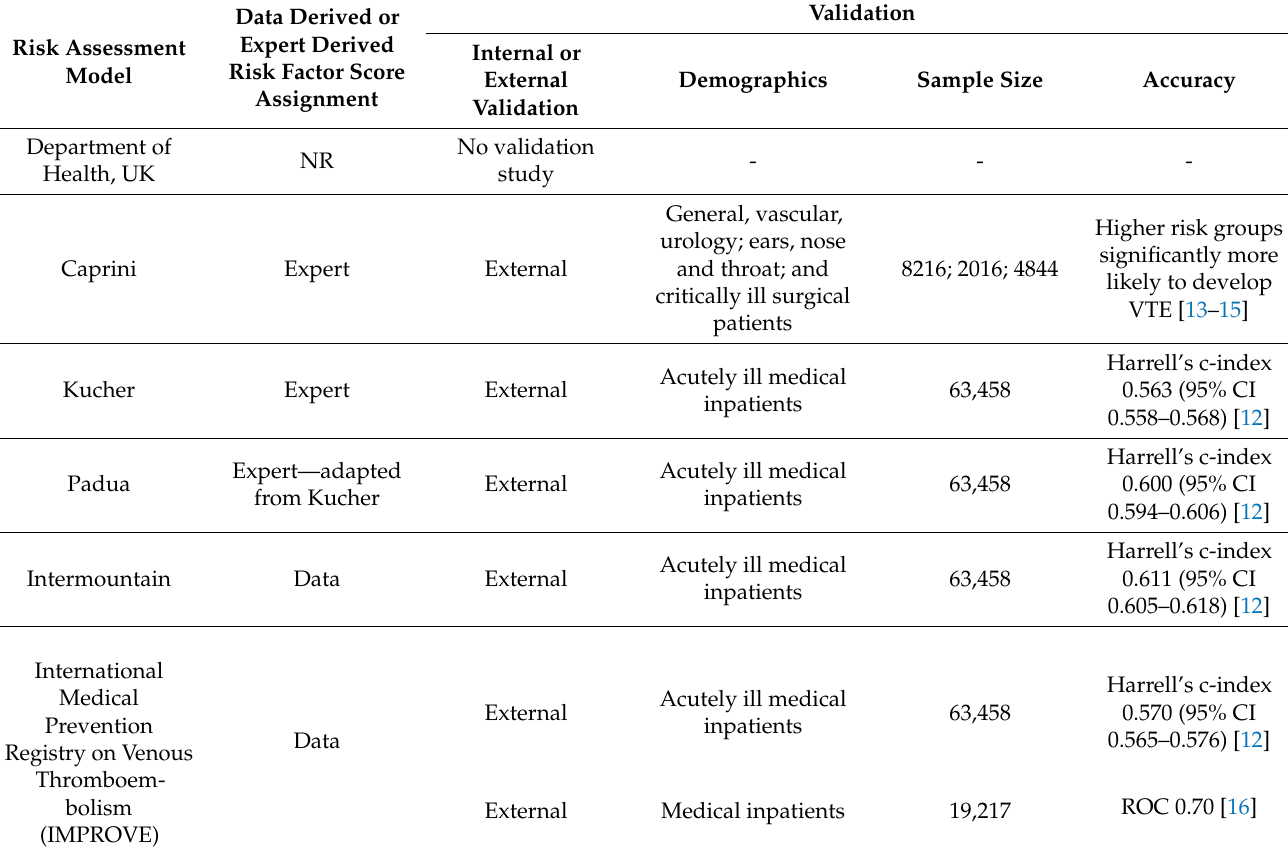
Table 1. Existing Risk Assessment Models (RAMs) development and